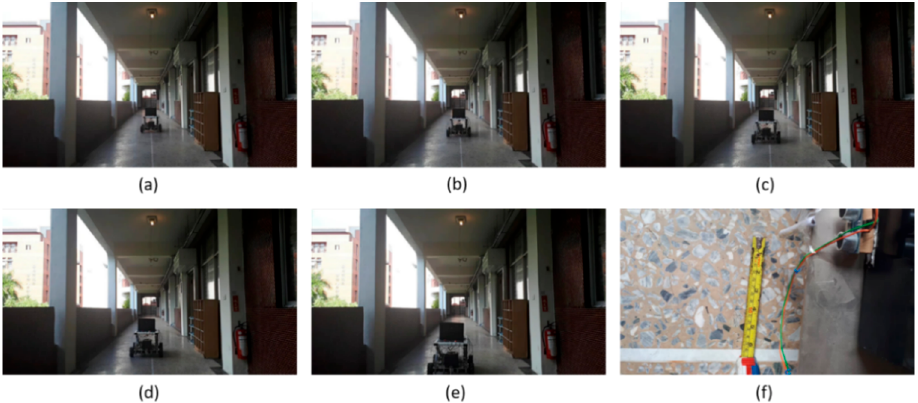
Figure 15. OMWAGV walking straight 400 cm without RLS estimation compensation. ( a ) Starting position, ( b – e ) at middle way, and ( f ) deviation at stop position.